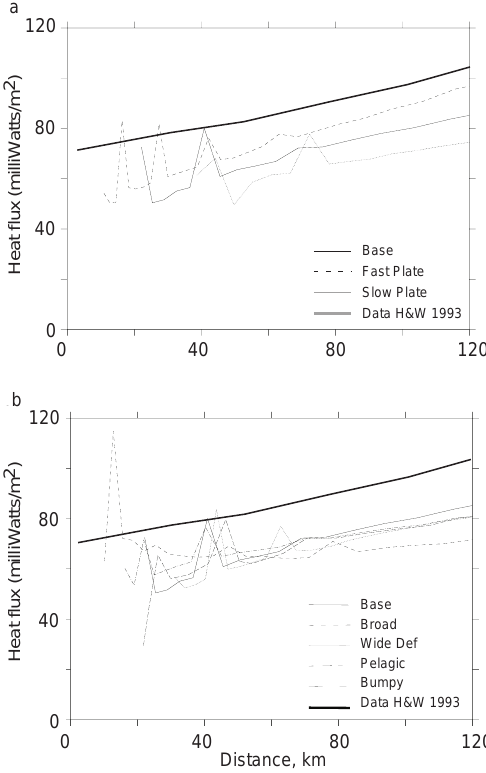
Fig. 7. Diffusive heat flow results compared with data from Hyn- dman and Wang (1993). (a) and (b) are various model scenarios as indicated. Other cases are shown in the Supplement file heat- flux.pdf.